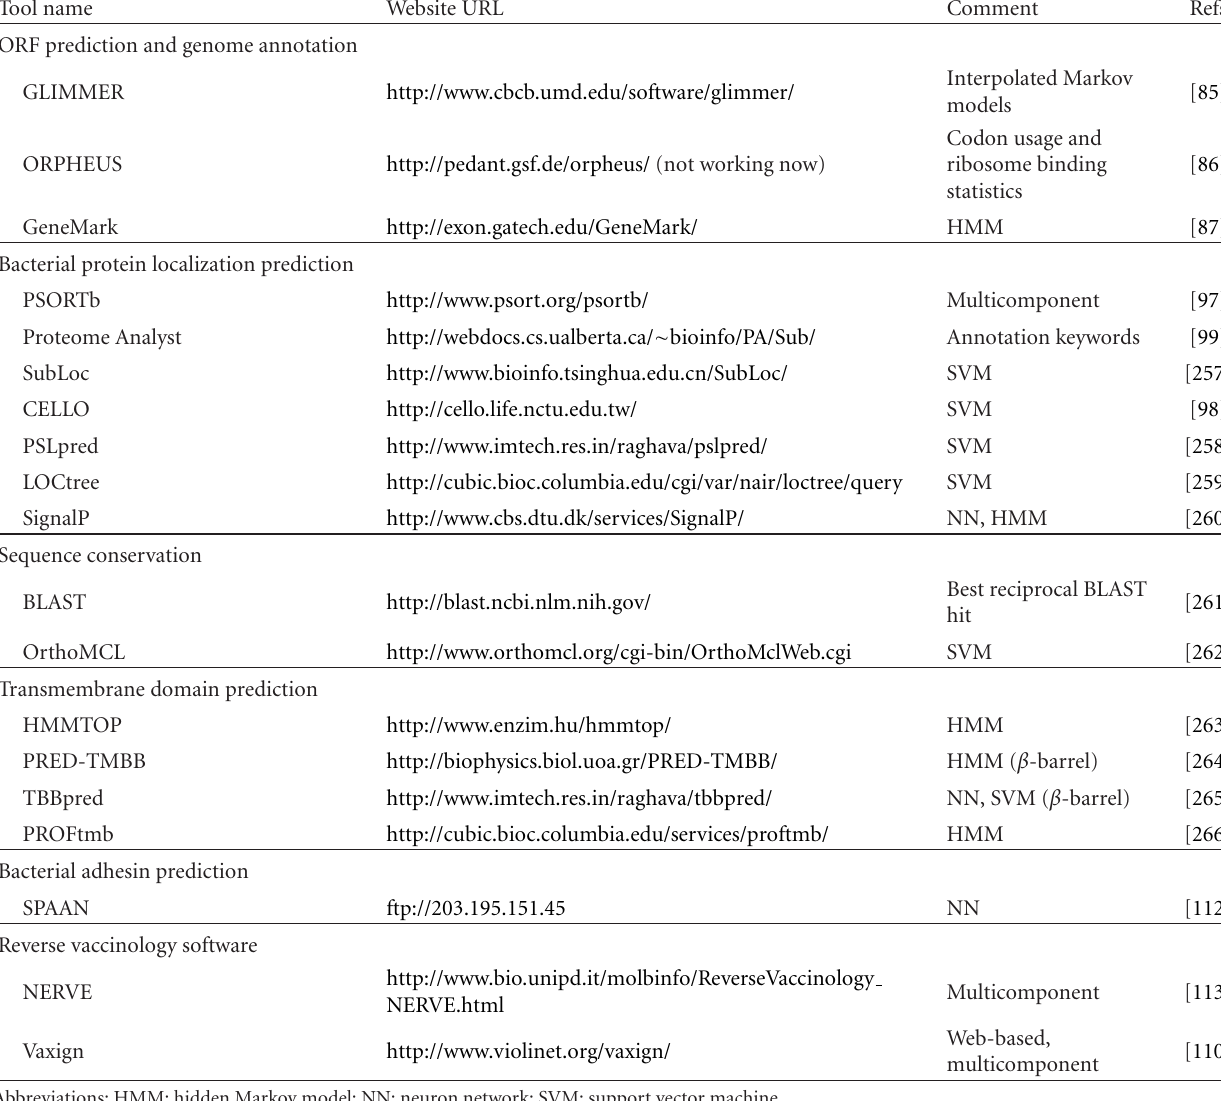
Table 2: Tools used for reverse